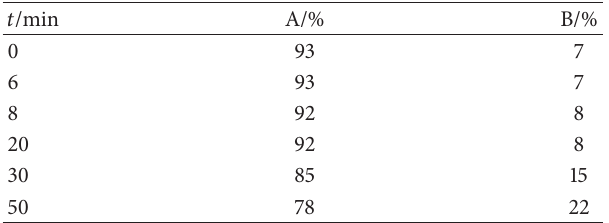
Table 1: Conditions of the mobile phase